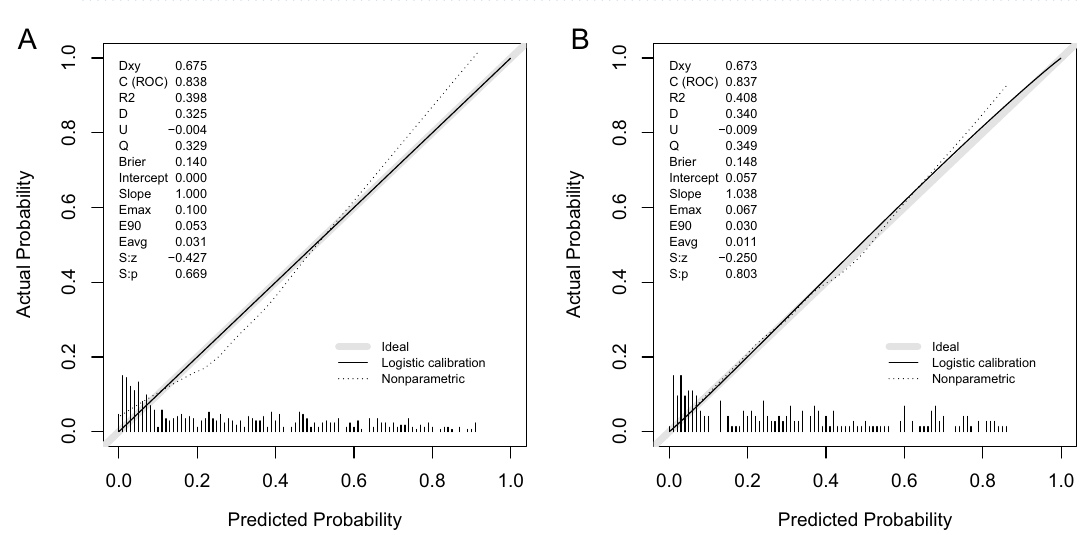
Figure 2. The nomogram predicted risks were compared across categories of PHASES score. Unruptured aneurysms were classified into low (PHASES < 5), medium (PHASES 5–9), and high (PHASES > 9) rupture risk subgroups. The medium nomogram predicted rupture risks were compared between these groups in the training ( A ) and testing ( B ) set, respectively.